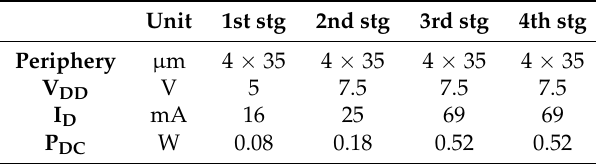
Table 3. The LNA stages’ biases and power